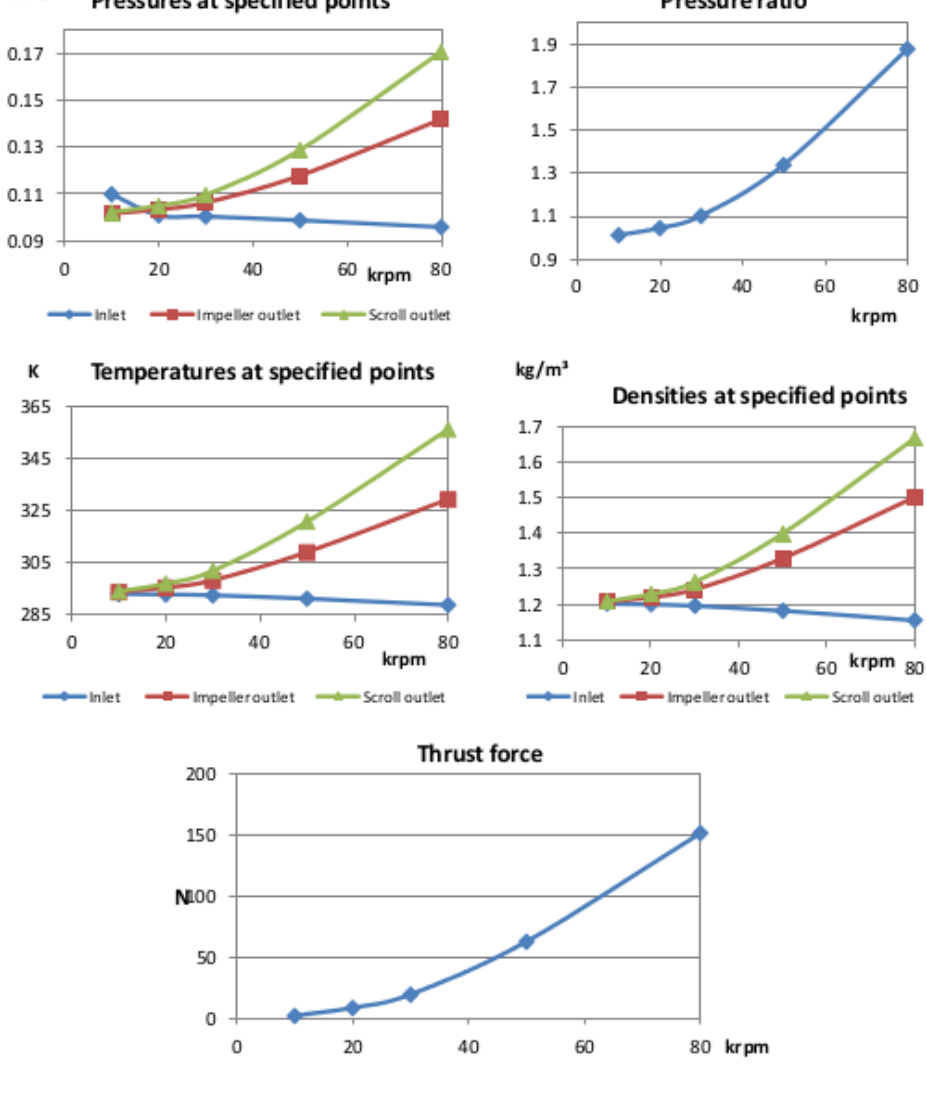
Figure 4: Calculated parameters of the reconstructed compressor stage.